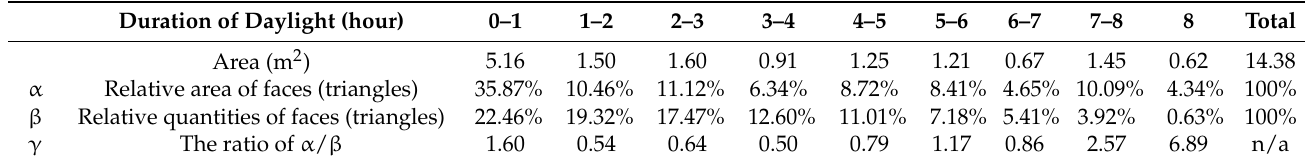
Table 3. Statistical table of daylight duration classified by